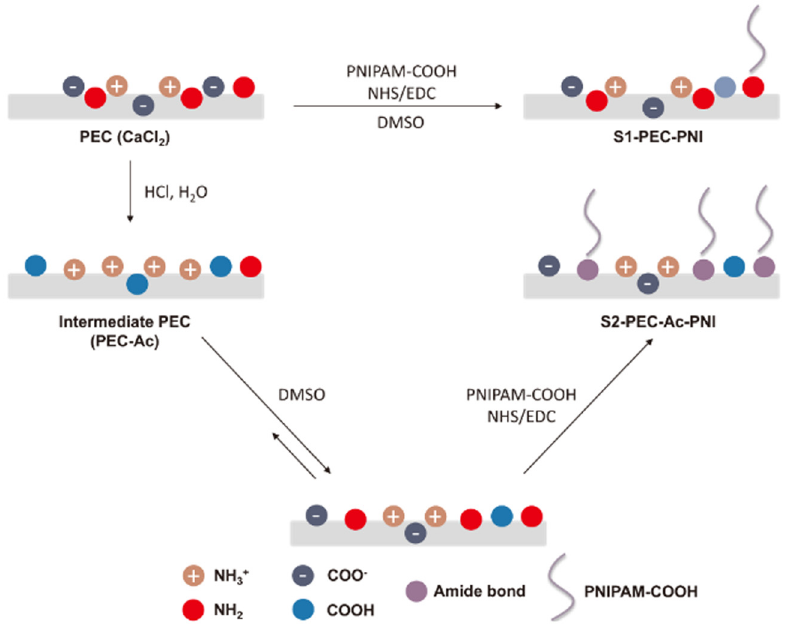
Figure 6: The PNIPAM - COOH was grafted on chitosan ’ s amines for cell adhesion via an NHS/EDC coupling ( reproduced from ref. [ 68 ])